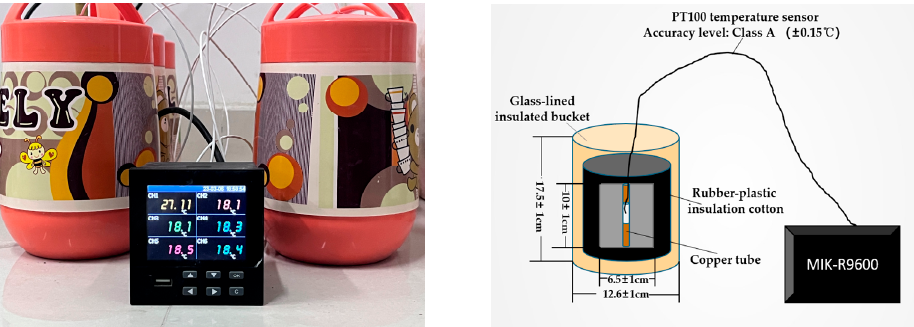
Figure 2. Semi-adiabatic calorimeter apparatus diagram and its cross-sectional view.